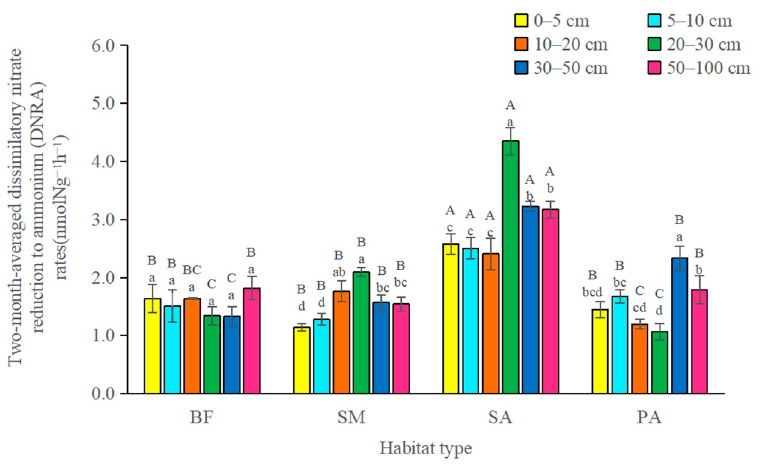
Figure 3. Two-month-averaged dissimilatory nitrate reduction to ammonium (DNRA) rates. Error bars in the column represent standard errors. SM: S. mariqueter ; SA: S. alterniflora ; PA: P. australis ; BF: bare mudflat. Bars with different uppercase letters and lowercase letters denote significantly different in habitat types and soil depths, respectively ( p < 0.05).